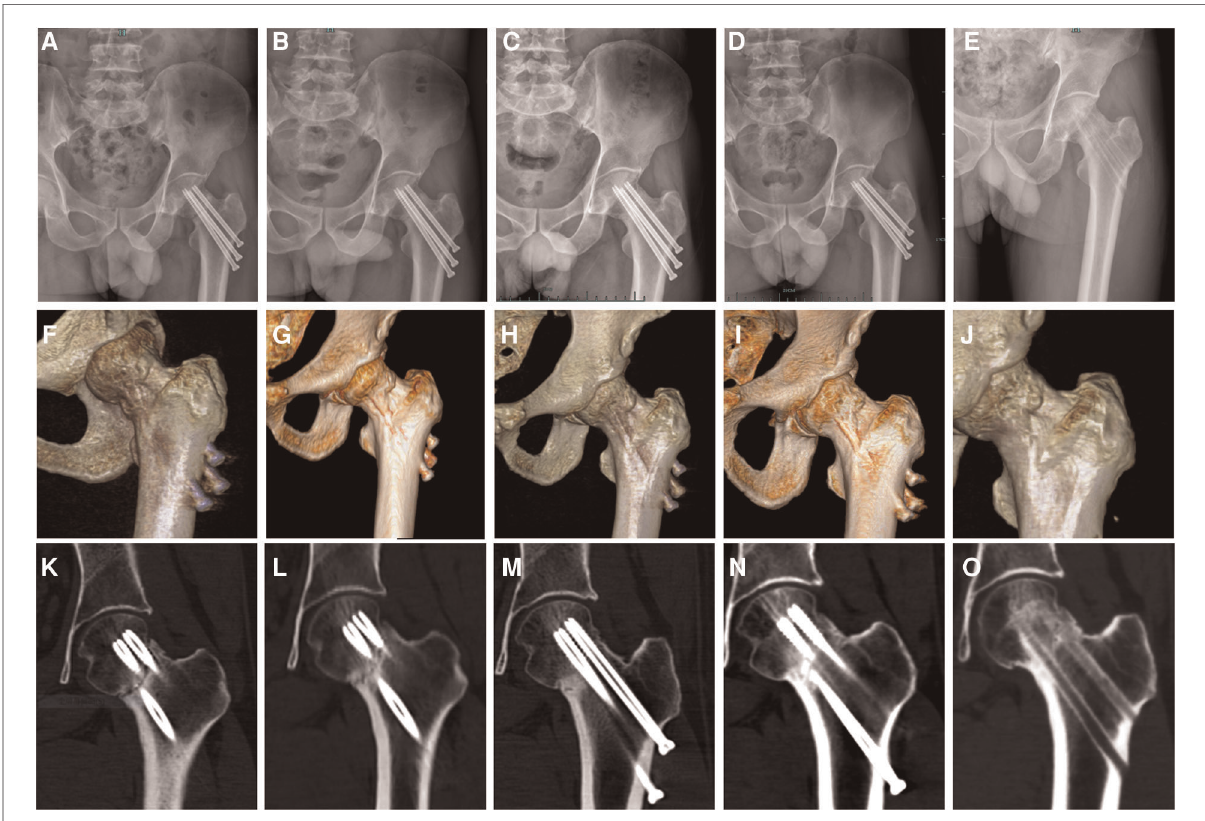
FIGURE 2 Radiological images ( A, F, K ) showing trabeculae bridging through fracture sites and a reduction of the fracture space after 3 months of taking the drug. Representative images of the patient regularly reviewed while taking medication ( B, G, L ). The x-ray ( C ) and CT fi lm ( H, M ) showing the bone healing completely after 6 months of stopping the drug. Representative images of the patient regularly reviewed after drug withdrawal ( D, I, N ). Internal fi xation screws were removed in July 2021 ( E, J, O ) when the patient returned to normal activity feeling no